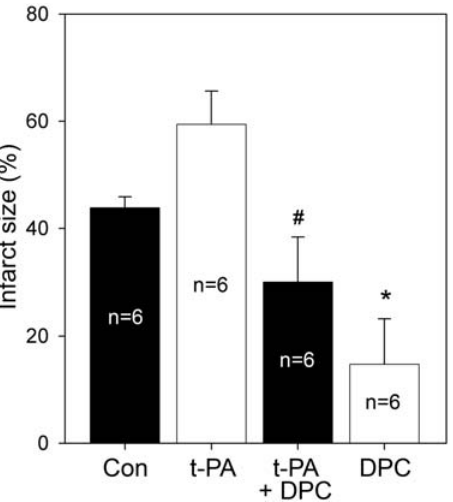
Figure 9. Delayed postconditioning (DPC) attenuated t-PA ’ s worsening effect on infarction . T-PA (2 mg/kg) was injected intravenously for 1h started at 5 h after ischemia of 30 min bCCA occlusion plus permanent dMCA occlusion; postconditioning with 6 cycles of 15 min occlusion/15 release of the left CCA was performed from 6 h after stroke. Rats were killed 48h later for TTC staining and infarct size measurement. T-PA injection significantly worsened ischemic injury compared with control ischemia; delayed postcondi- tioning attenuated its exacerbating effect. N=6/group. * P , 0.05 vs con or t-PA; # P , 0.05,vs t-PA (ANOVA on